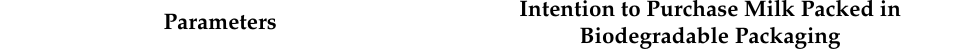
Table 2. The structural model of the consumer’s intention to buy foods packed in sustainable packaging and then to purchase milk packed in biodegradable packaging. Intention to Purchase Milk Packed in Parameters Biodegradable Packaging Coefficient Intention to buy foods packed in 0.555 *** sustainable packaging